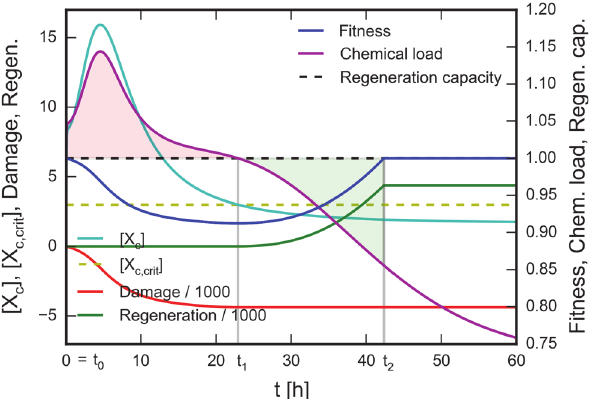
Fig 5. Modeling cellular fitness to study cytotoxic effects. Calculation of cellular fitness by assuming a single toxic compound, X. Cytoplasmic concentration of the drug ([X c ]) was calculated using the time course simulation described in Methods. Critical concentration of X c ([X c,crit ], dashed yellow line) was defined as the threshold concentration, which must be exceeded to cause cellular damage. Chemical load is defined as a nonlinear function of the [X c ]/[X c,crit ] ratio (magenta curve). The cell is assumed to have a constant Regeneration capacity (dashed black line). When Chemical load exceeds Regeneration capacity (t0 < t < t1) , the cell undergoes damage. Cellular damage is represented by the Damage variable (red curve), which has nonpositive values proportional to the light red shaded area. When Chemical load is below Regeneration capacity and Fitness is below of its maximal value (t1 < t < t2) , the cell undergoes regeneration. Regeneration is represented by the Regeneration variable (green curve), which has nonnegative values proportional to the green shaded area. When Chemical load is below Regeneration capacity but Fitness is maximal (t2 < t) , nor damage, neither regeneration occurs. Fitness (blue curve) is calculated by adding the (scaled) nonnegative values of Regeneration and the (scaled) nonpositive values of Damage to the maximal value of Fitness . See text for